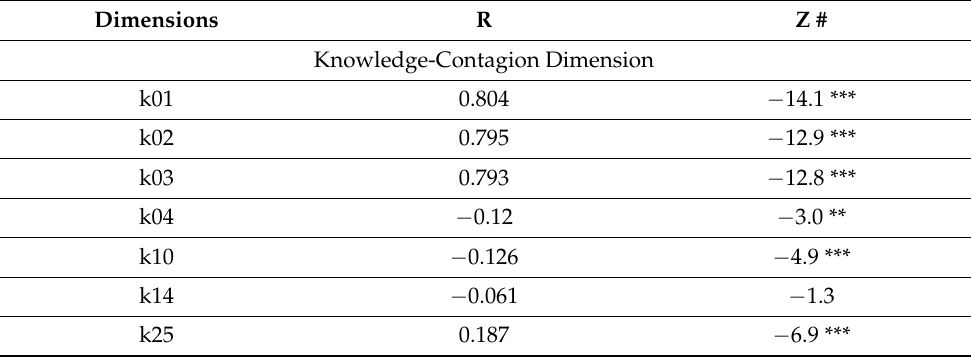
Table A2. Item-total correlation coefficients and Mann Whitney U test results (for item